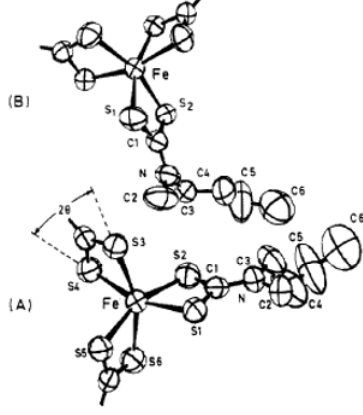
Figure 3. Structure of [Fe III ( η 2 -MeBuNCS